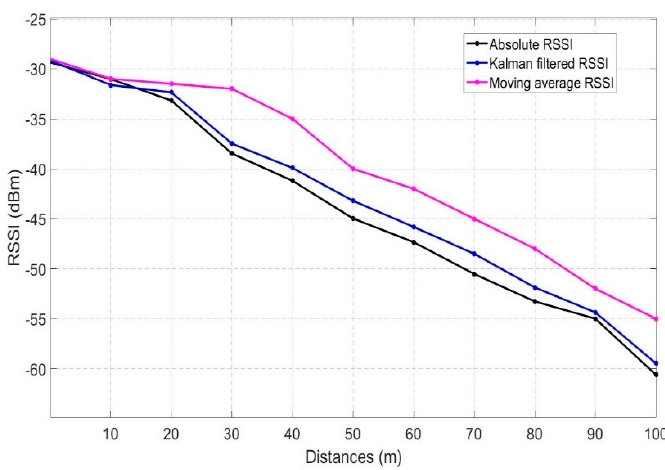
Figure 3. RSSI comparison of absolute, Kalman filtered values and moving average values.